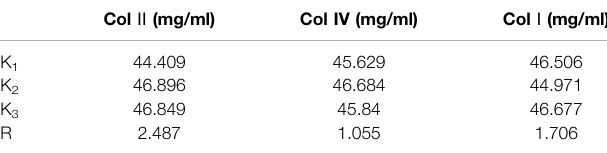
TABLE 3 | Range analysis of collagenases combinations on cell viability during kidney tissue